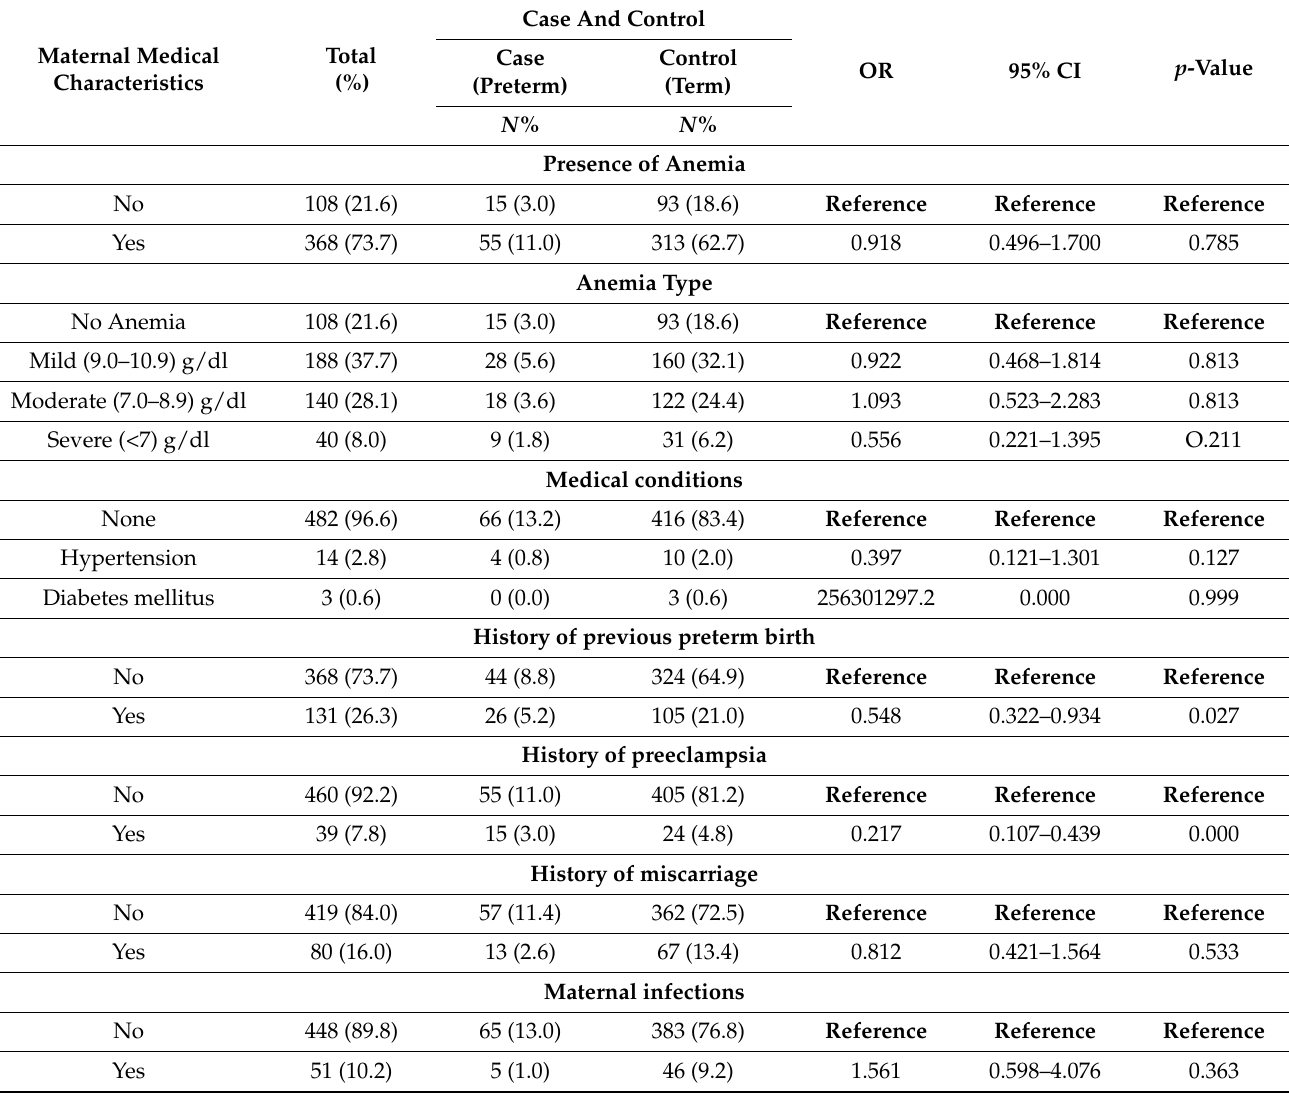
Table 3. Maternal medical factors and preterm birth among pregnant women delivered in four hospitals, Mogadishu,